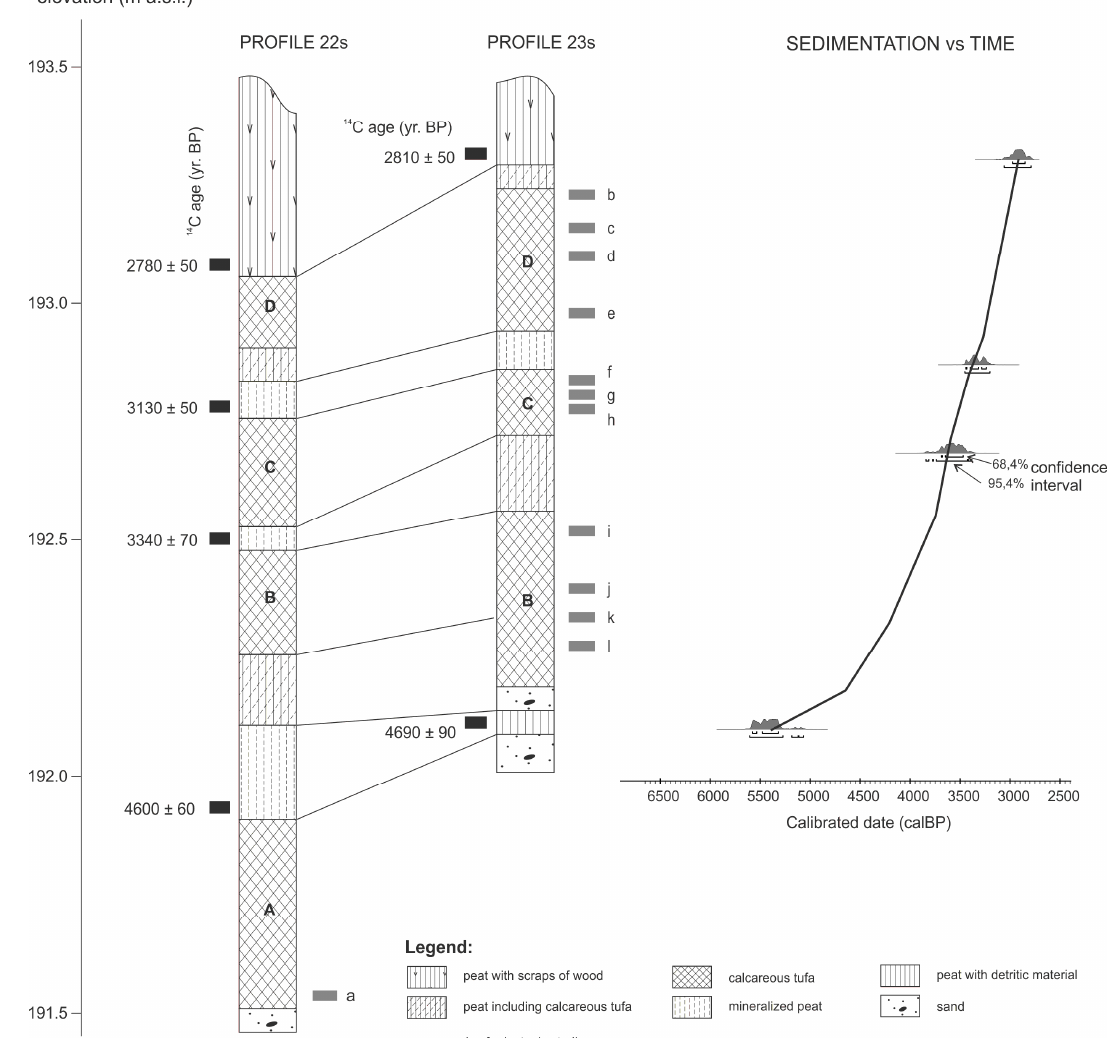
Figure 5. Sedimentary rate model constructed with the use of OxCal software [14] based on the IntCal 13 curve.